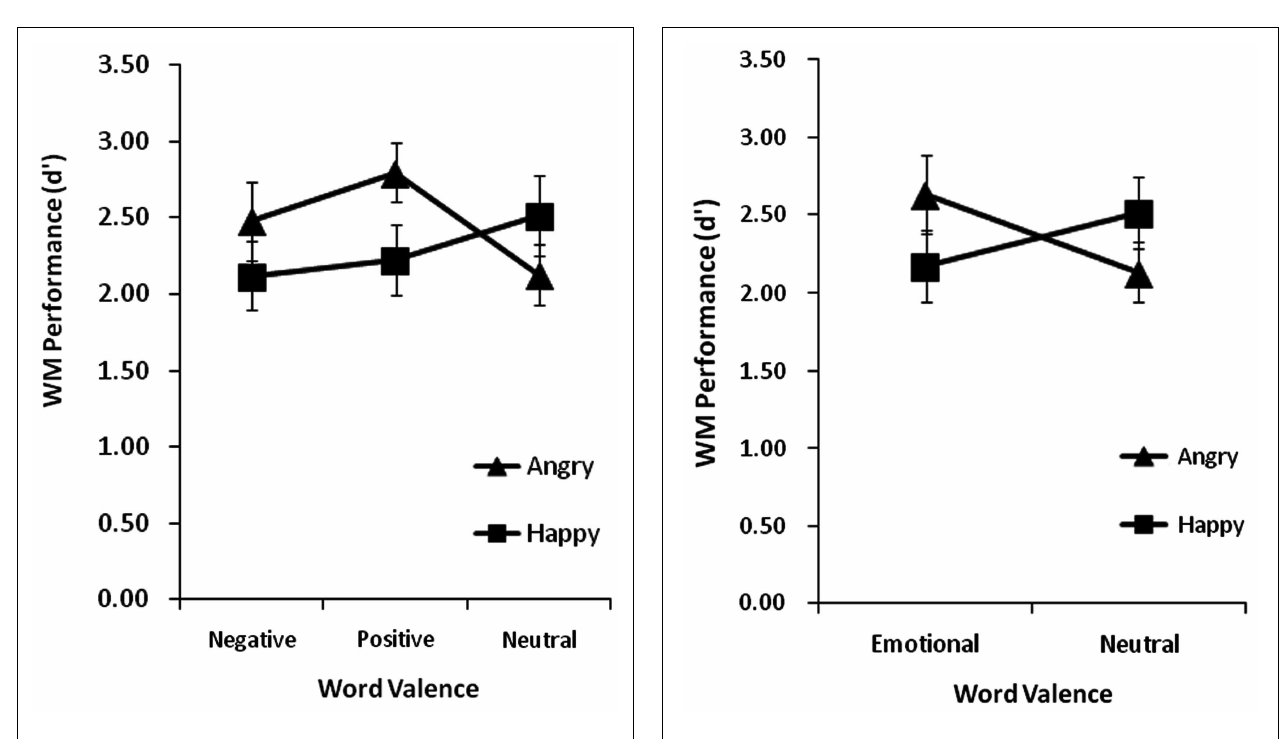
FIGURE 4 | Group meanWM performance measured in d (cid:48) when allWM memoranda faces had happy or angry expressions and the incidental words presented during the retention interval were emotional or neutral. Vertical lines represent ± 1